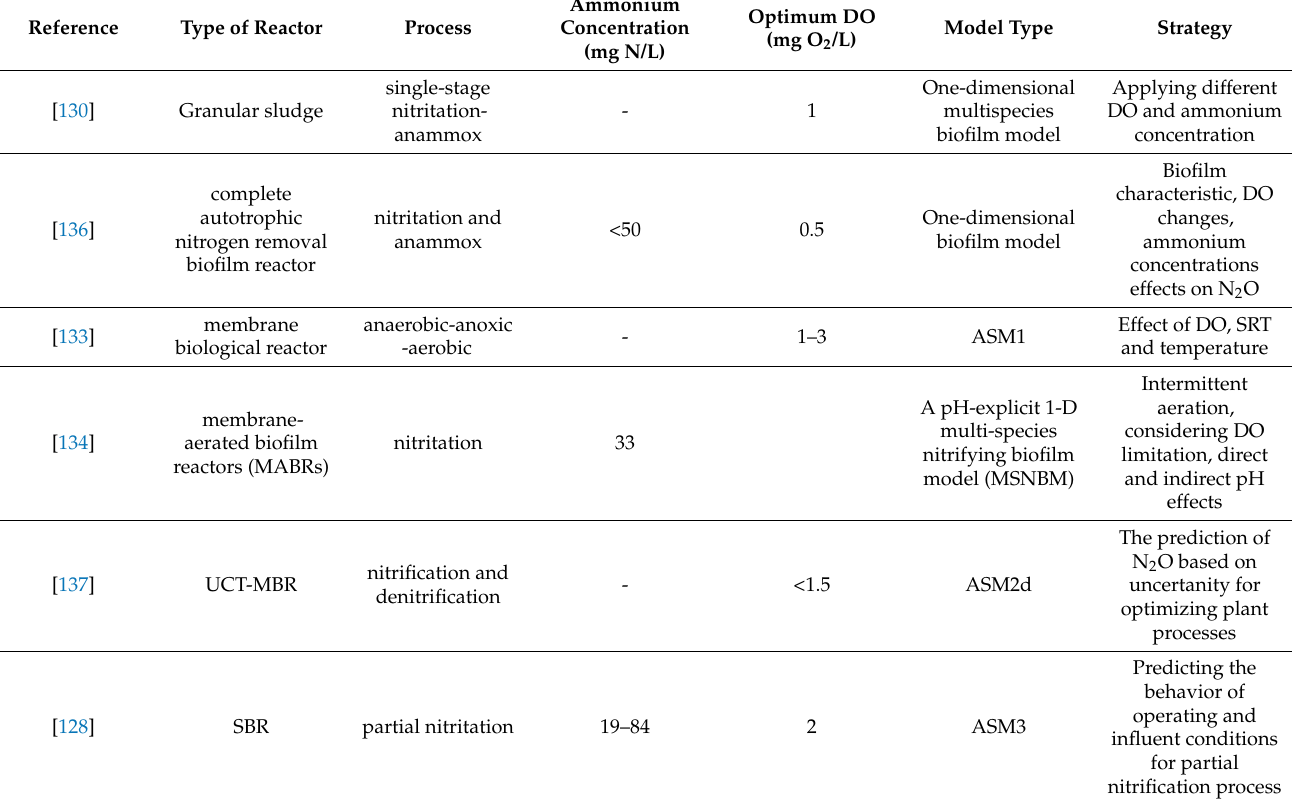
Table 4. The application of different mathematical models within nitrogen removal